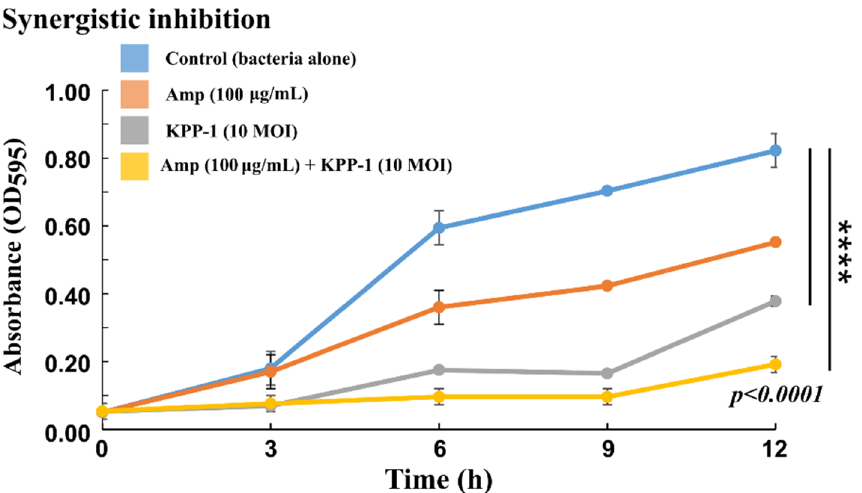
Figure 6. Synergy of K. variicola growth suppression. Synergistic suppression of K. variicola upon co-incubation with KPP-1 and ampicillin is demonstrated. The lowest bacterial growth was observed when both KPP-1 and ampicillin were used in combination. The suppression of KPP-1 at the 10 MOI level was shown to be more potent than ampicillin alone. **** indicates significant difference between antibiotic and phage-free control. The significant difference was determined at p < 0.05.